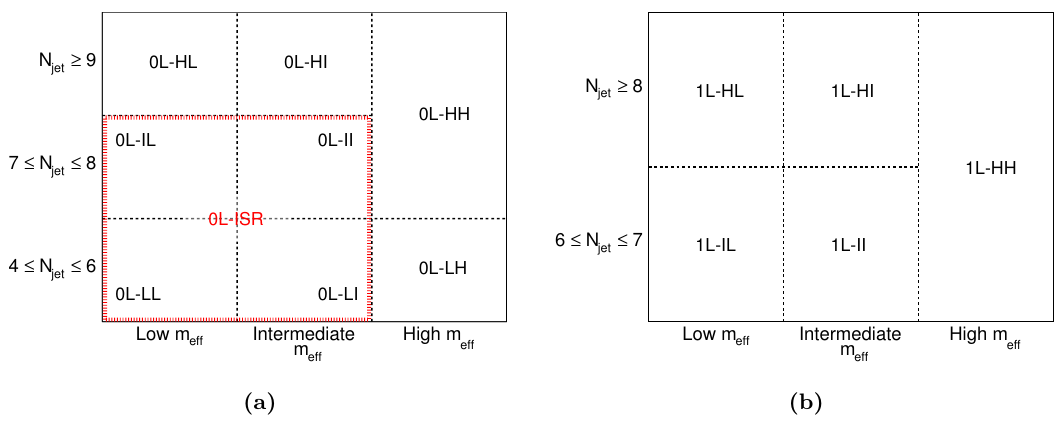
Figure 5. Scheme of the multi-bin analysis for the (a) 0-lepton and (b) 1-lepton regions. The 0L-ISR region is represented with the broad red dashed line in